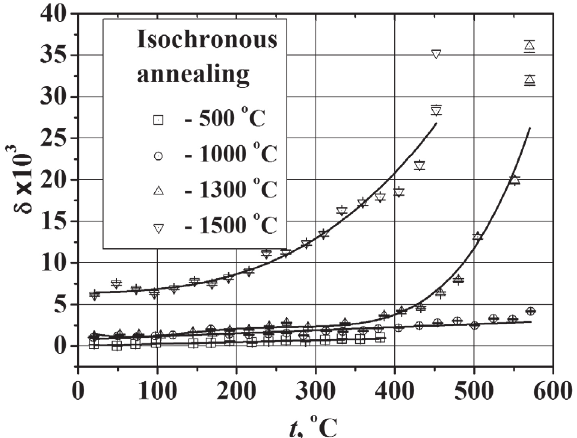
Figure 4. Temperature dependence of the shear modulus G of ir- radiated rhenium for various isochronous annealing